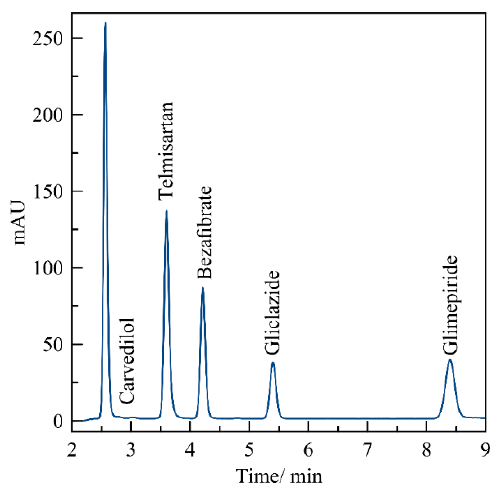
Figure 2. Chromatogram for the simultaneous determination of CVD, TEL, BZT, GZD and GMP at 10 μg mL −1 . Conditions: stationary phase, C 18 column, mobile phase acetonitrile: buffer phosphate pH 3 (50/50 v / v ), isocratic flow rate 1 mL/min and 25 °C.